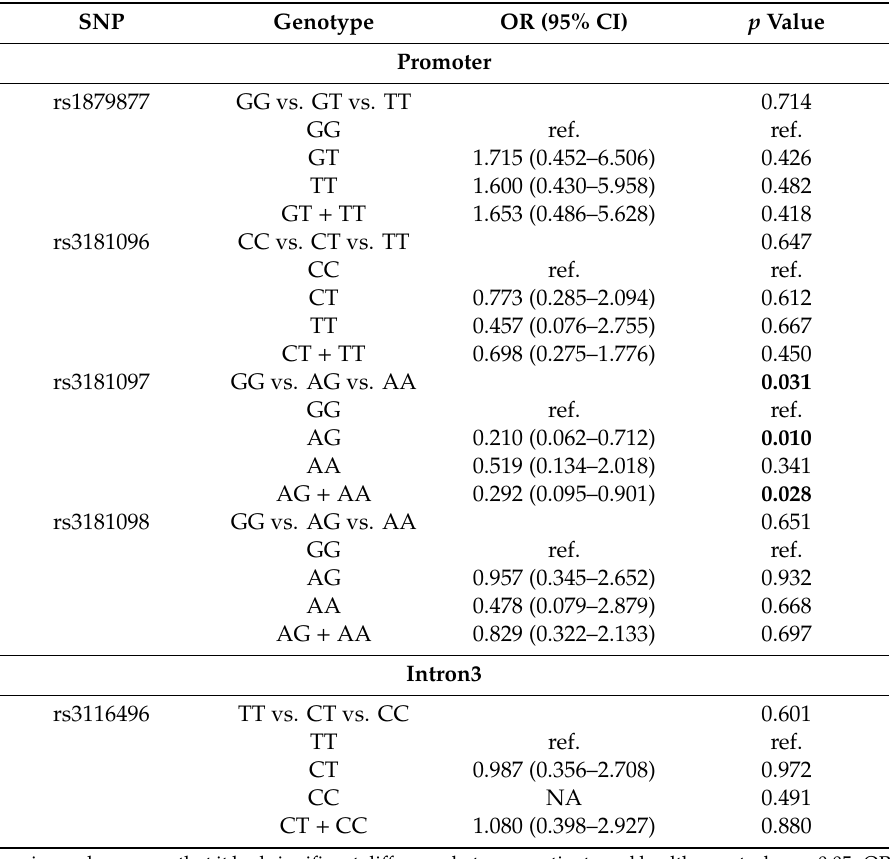
Table 4. Genotypes of CD28 SNPs and their correlations with risk of TR.